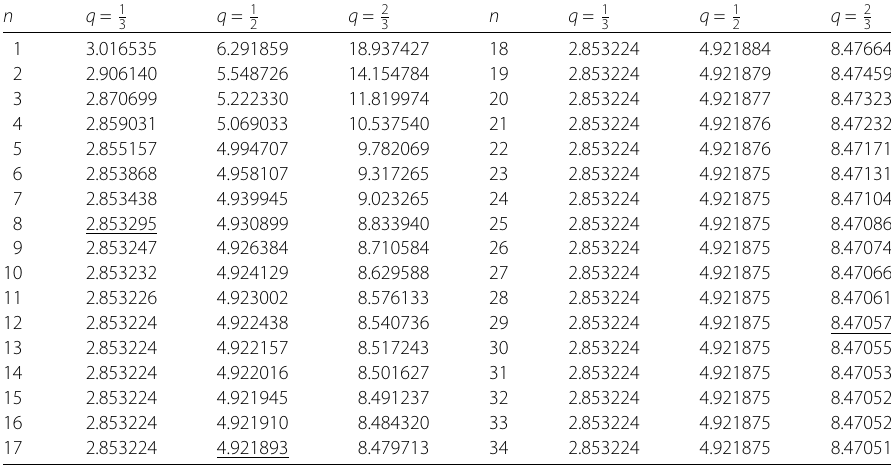
, 1 , 2 , x = 5 and n = 1,2, ... ,35 of 3 2 3